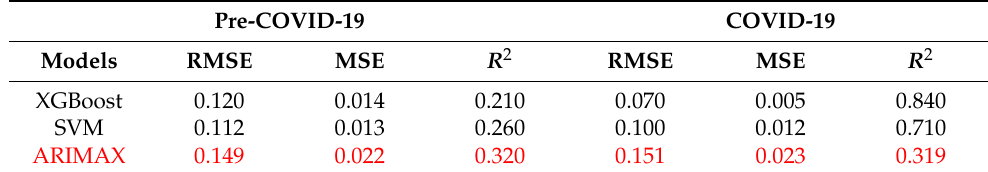
Table 2. Prediction performance assessment of the candidate models (Daily analysis).